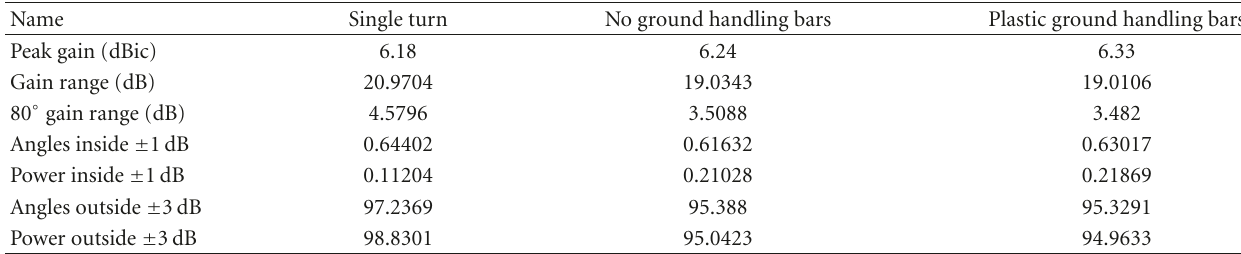
Figure 11: Assessment of radiation pattern of single turn helical antenna on the gondola normalised to θ = 80 ◦ minima; (a) flattened hemisphere plot of gain comparison to ideal radiation pattern shape, (b) radiation pattern power distribution in relation to ideal radiation pattern shape, from FEKO. Table 2: Summary of figures of merit for gondola modification